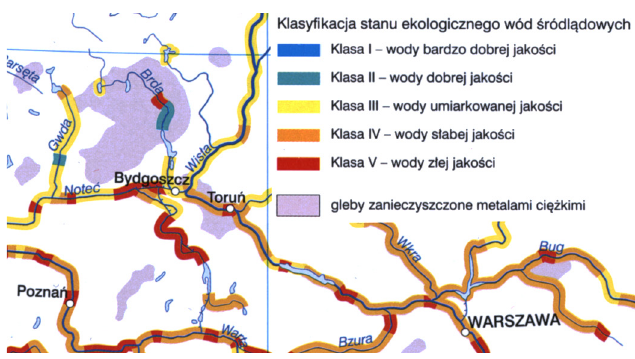
Fig. 8. Linear ordered symbols used to show the classes of river’s water quality